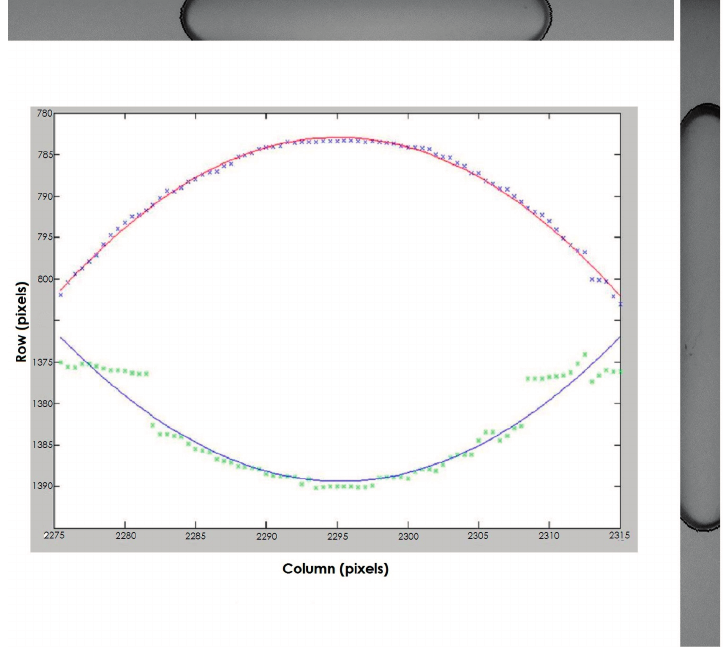
Figure 8. The portions of frame used for the measurement and the interpolating spiric sections obtained for the right